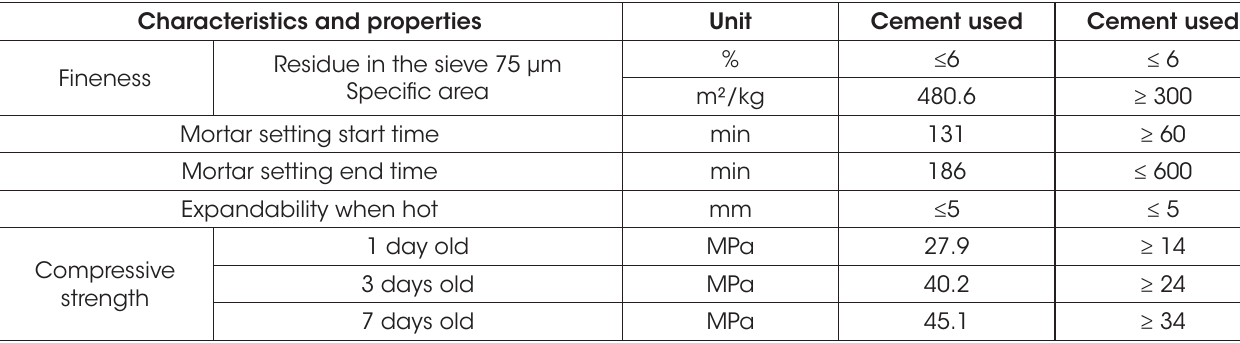
CP V ARI mechanical analysis according to NBR 5733